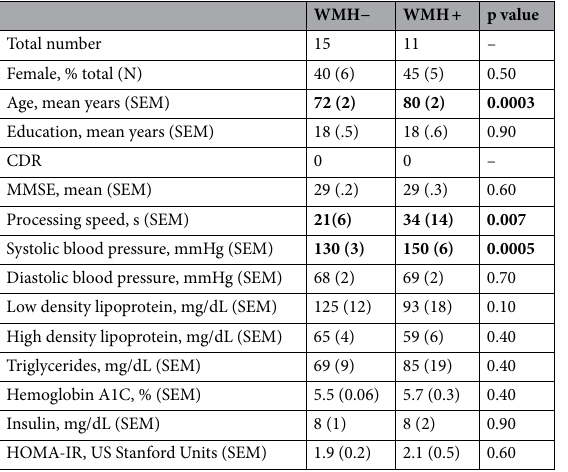
Table 1. Participant demographic, cognitive, and clinical data. Two-tailed Student’s t-tests or the non- parametric Wilcoxon rank sum were used for statistical comparison of continuous measures and Chi-squared tests were performed to compare group characteristics. Results are included in this table. Age, systolic blood pressure, and processing speed were the only significant different variables between